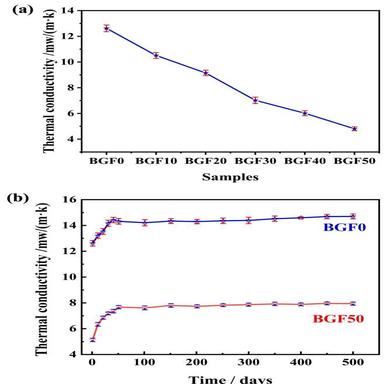
(a) thermal conductivity of the VIP as a function of glass fiber addition; (b) aging performance of VIPs.